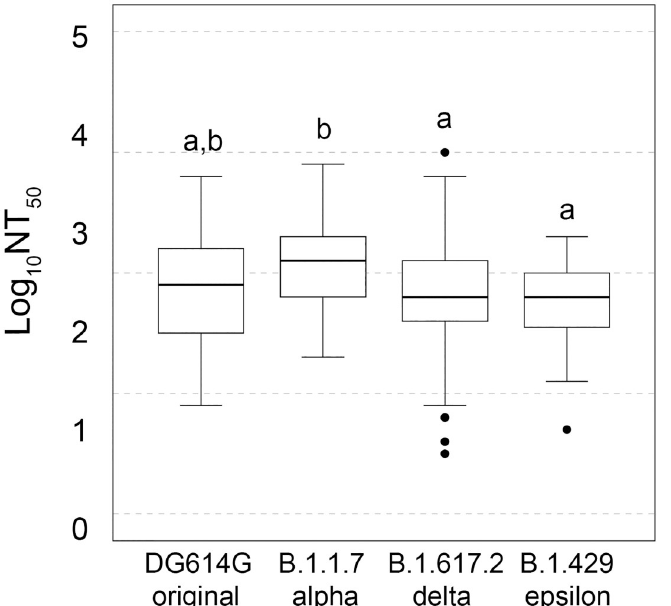
Fig 5. Neutralizing effect of selected sera among four variants. Box plot of NAb titers among variants. Subsets were established by Kruskal–Wallis followed by a post hoc Dunn’s test (adjusted alpha = 0.007). Different letters above bars denote significant differences between groups; the same letter indicates that they belong to the same